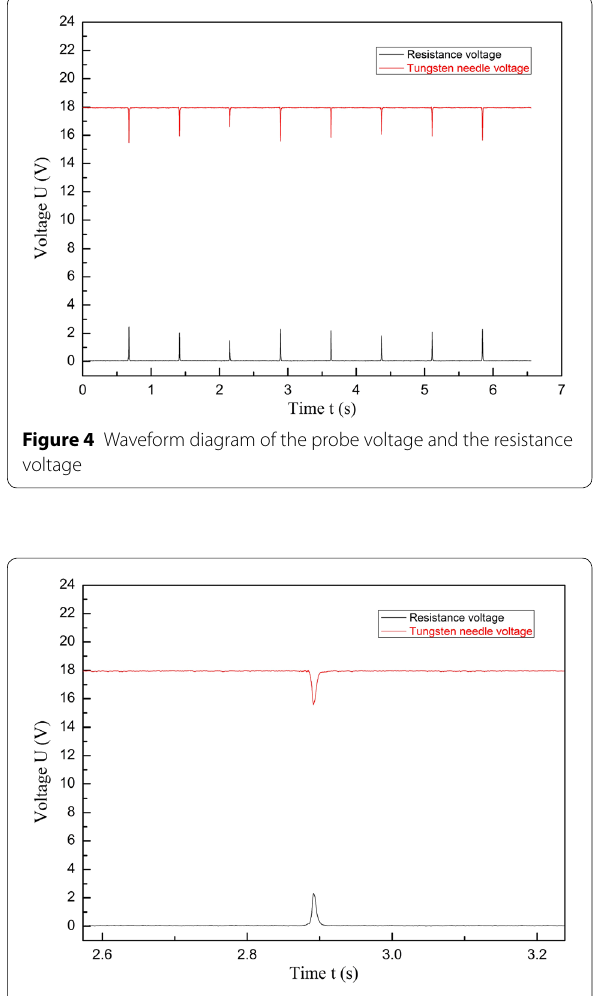
As shown in Figure 6, the processes occurring when the probes rotated into the plasma arc were captured and recorded in real time using a high-speed camera.